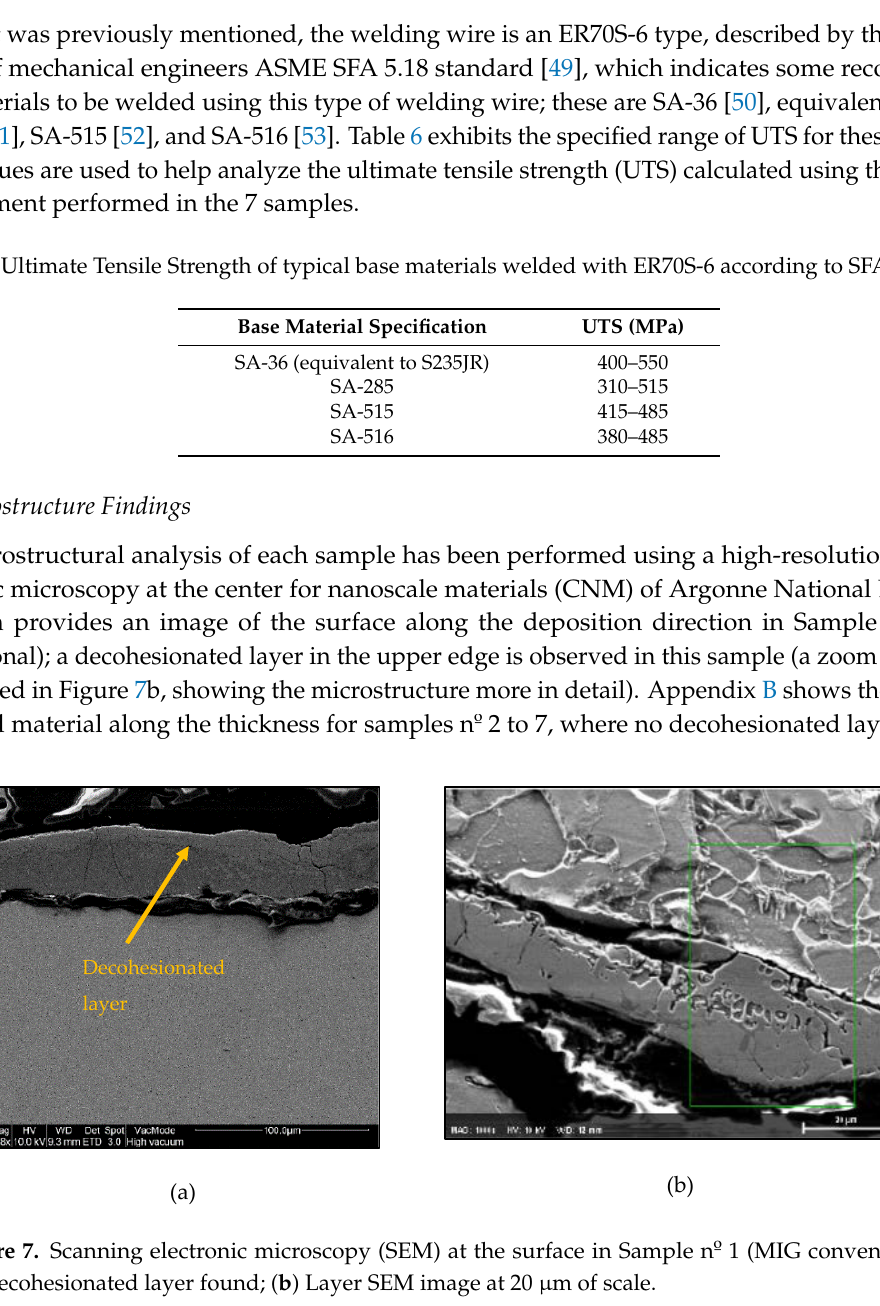
Figure 7. Scanning electronic microscopy (SEM) at the surface in Sample nº 1 (MIG conventional). ( a ) Decohesionated layer found; ( b ) Layer SEM image at 20 µm of scale. Table 7 provides the compositional microanalysis of this layer observed in sample nº 1. Table 7. Microanalysis of decohesionated external layer observed in Sample 1 (MIG conventional process).